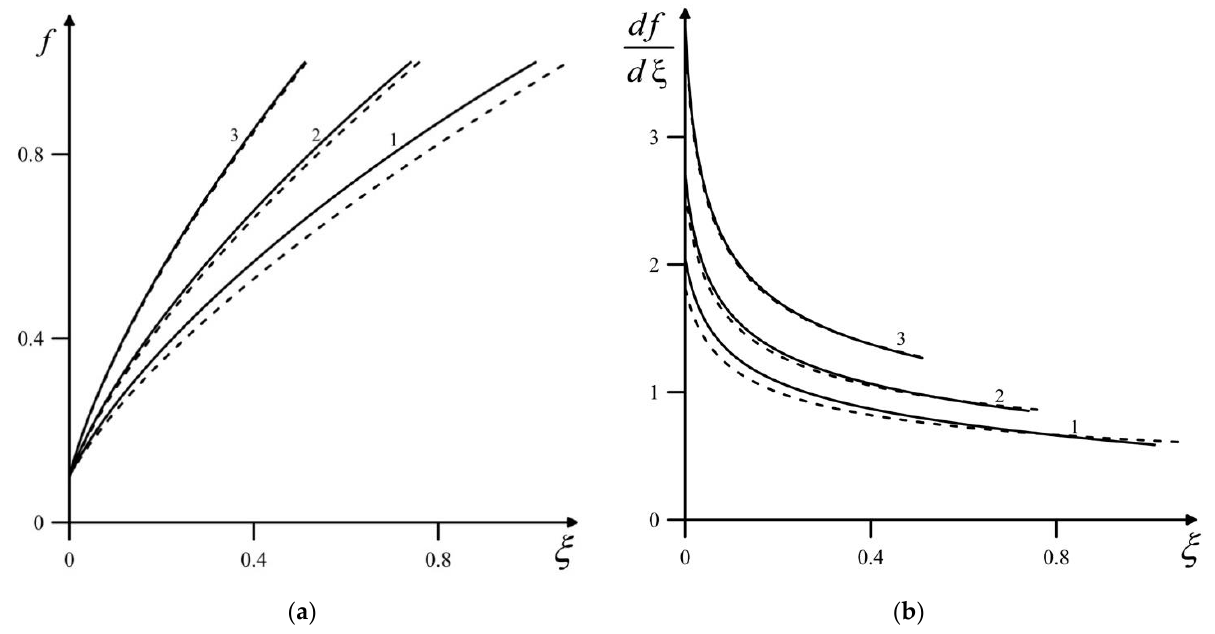
Figure 4. Self-similar solution of the problem ( a ) and its derivative ( b ) for m = 1.1, f 0 = 0.1, f 0 = 1.1; 1.3; 2 ( 1 − 3 ) . Solid lines represent the numerical solutions, while dotted lines correspond to approximate analytical solutions.